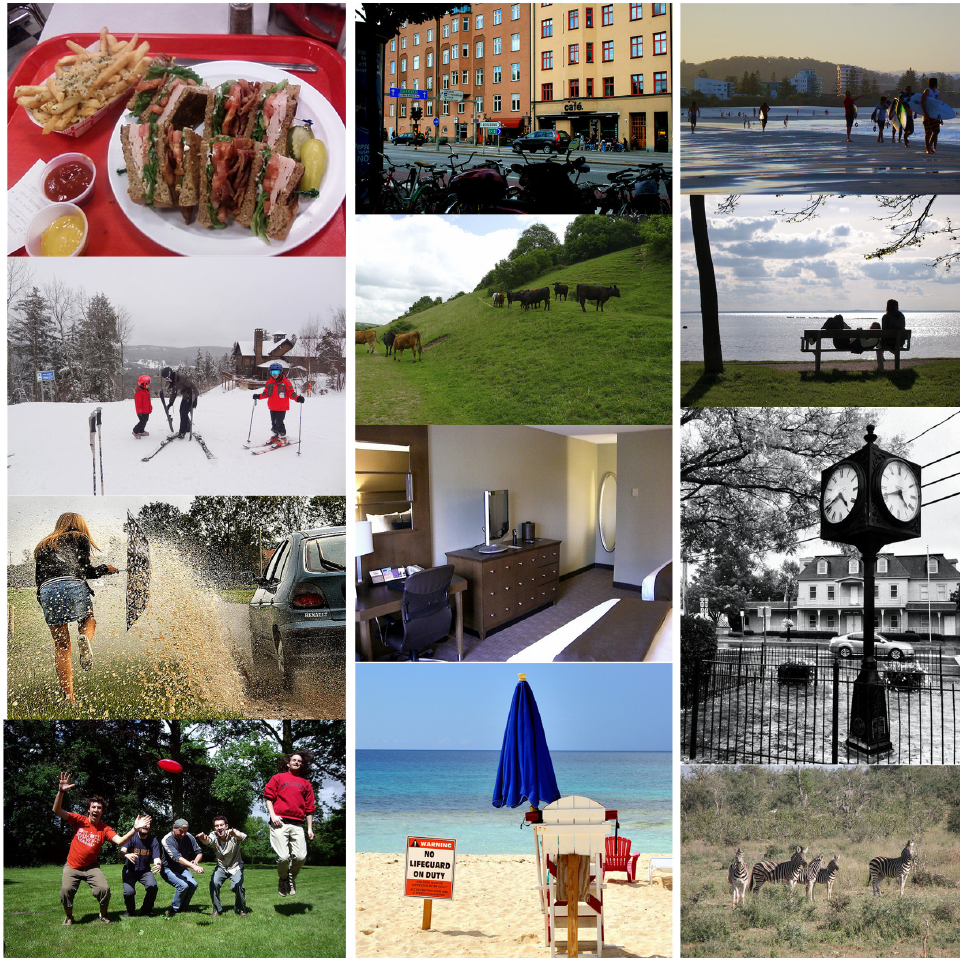
Figure 6. Some images in COCO2017 datasets. The dataset has the characteristics of rich categories, large number, diverse scenes, and large scale range, which makes high detection performance very